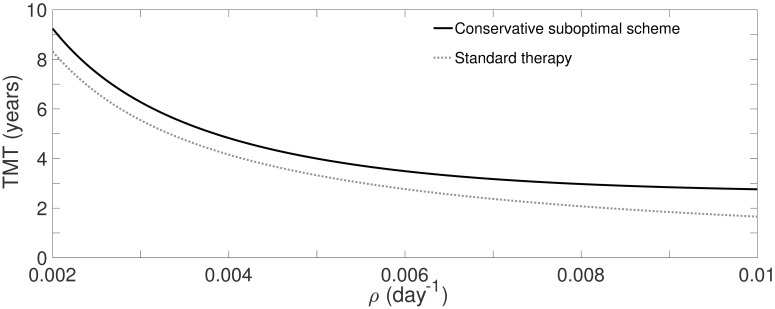
Benefit quantification of the conservative suboptimal treatment, Δsubopt = 6 days, against the standard one for ρ ∈ [0.002, 0.01].